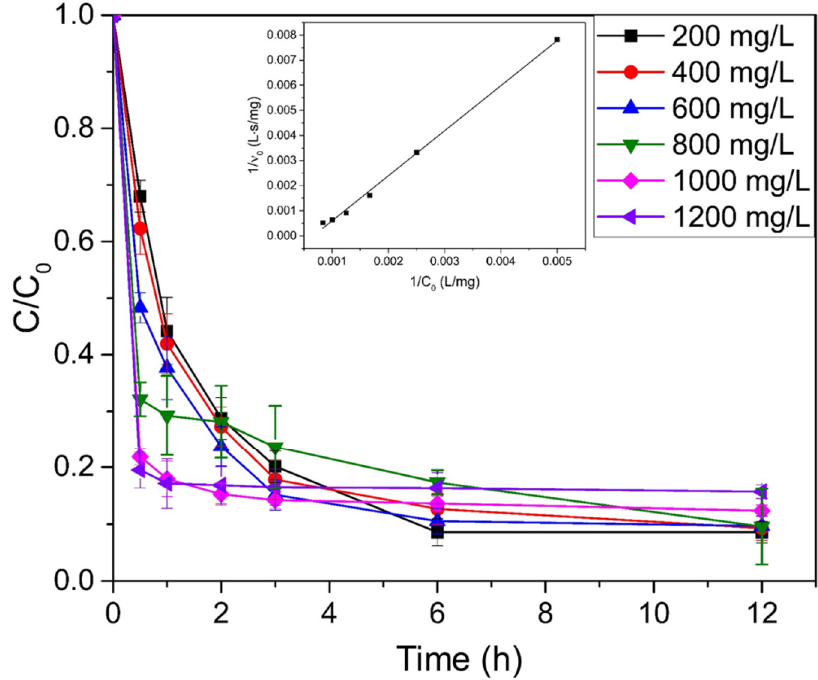
Figure 6. Effect of initial TC concentration on the catalytic degradation of TC and (inset) the Langmuir–Hinshelwood (L-H) plot (conditions: C 0 = 200–1200 mg/L, pH 3.2 (natural), H 2 O 2 concentration = 5 mM, catalyst concentration = 1 g/L, T = 28 ± 2 °C).